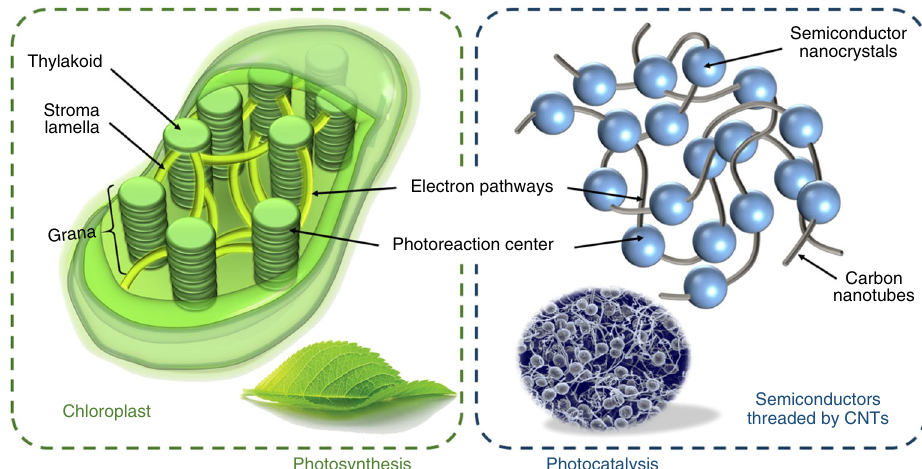
Fig. 1 The design principle of the chloroplast structured catalyst. Top view of chloroplast structure (left) and the architecture of the non-continuously distributed semiconductors threaded by CNTs